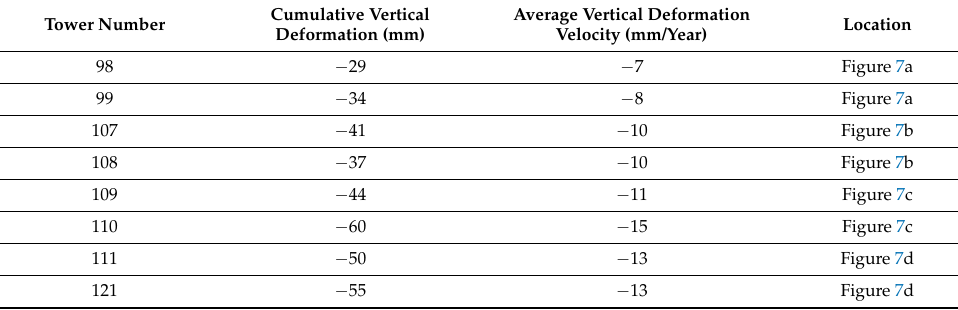
Table 3. Typical tower vertical deformation